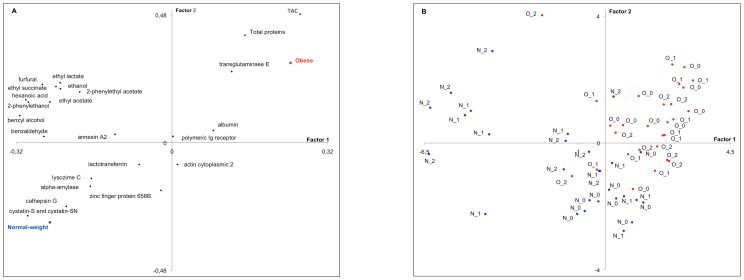
PLS-DA calibration modelling.Weighted loading plot (A) and scatter plot of scores (B) for X-variables, and their inner relationships with O (red •) and N (blu •) for the first two latent variables (43% of the total variance in the X-block; 56% of the total variance in the Y-block).